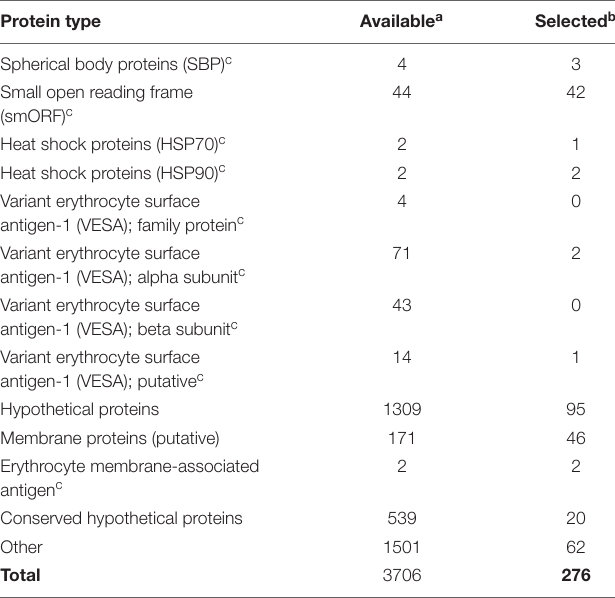
TABLE 1 | Breakdown of protein types meeting the rule-based exportome selection criteria. Protein